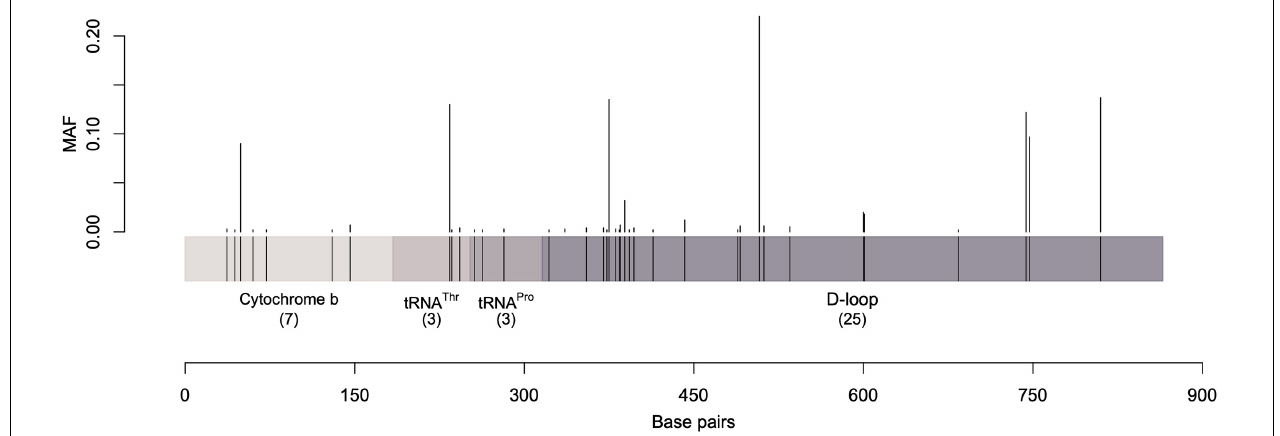
FIGURE 1 | A graphical representation of the sequenced mtDNA fragment along with the parsimony informative sites and their minor allele frequency. Vertical lines represent the minor allele frequencies (MAF) of parsimony informative sites. Singletons were